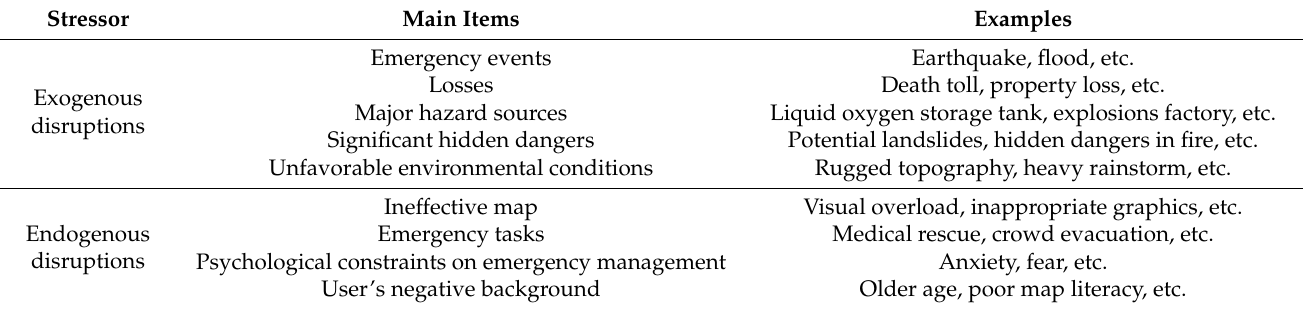
Table 1. Stressors affecting users’ map cognition under